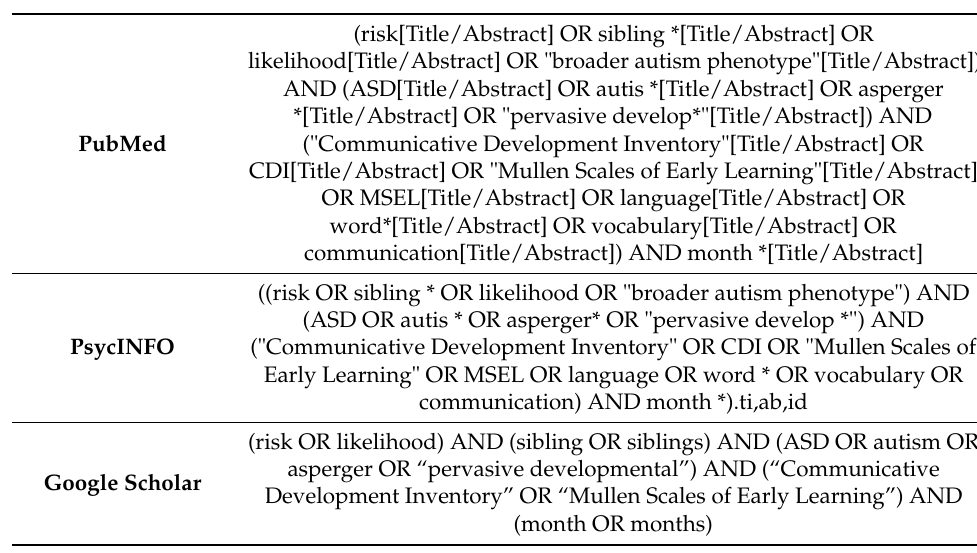
Table 1. Search in PubMed, PsychInfo, and Google